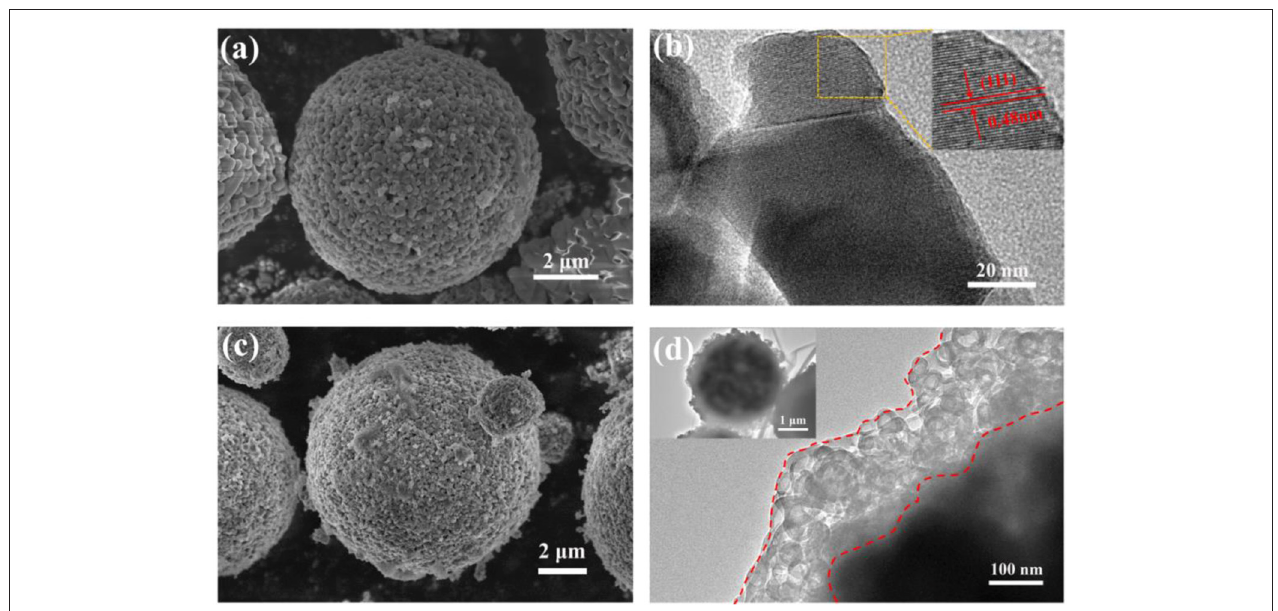
FIGURE 1 | SEM micrographs of (a) LTO and (c) AlF 3 -coated LTO; TEM micrographs of (b) LTO with inset showing a magnification of the area outlined in yellow with fringes across the (111), and (d) AlF 3 -coated LTO with inset showing a whole particle at lower